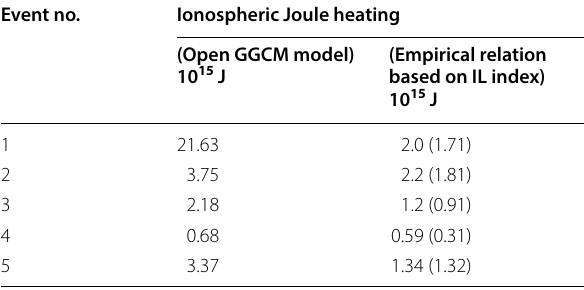
The values within brackets represent ionospheric Joule heating estimated from Ahn’s empirical relation based on the AL index